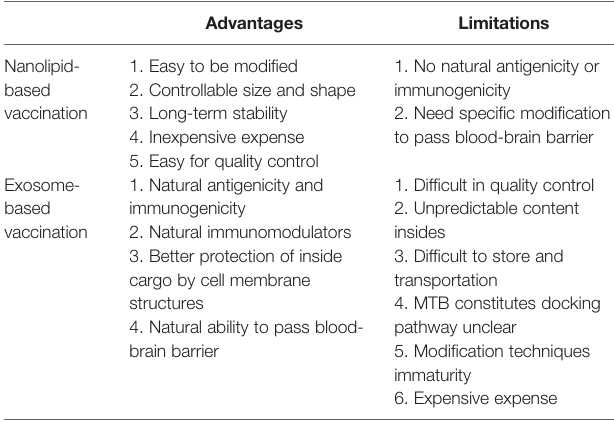
TABLE 2 | Advantages and limitations of exosomes compared with nanolipids (lipid nanoparticles) for